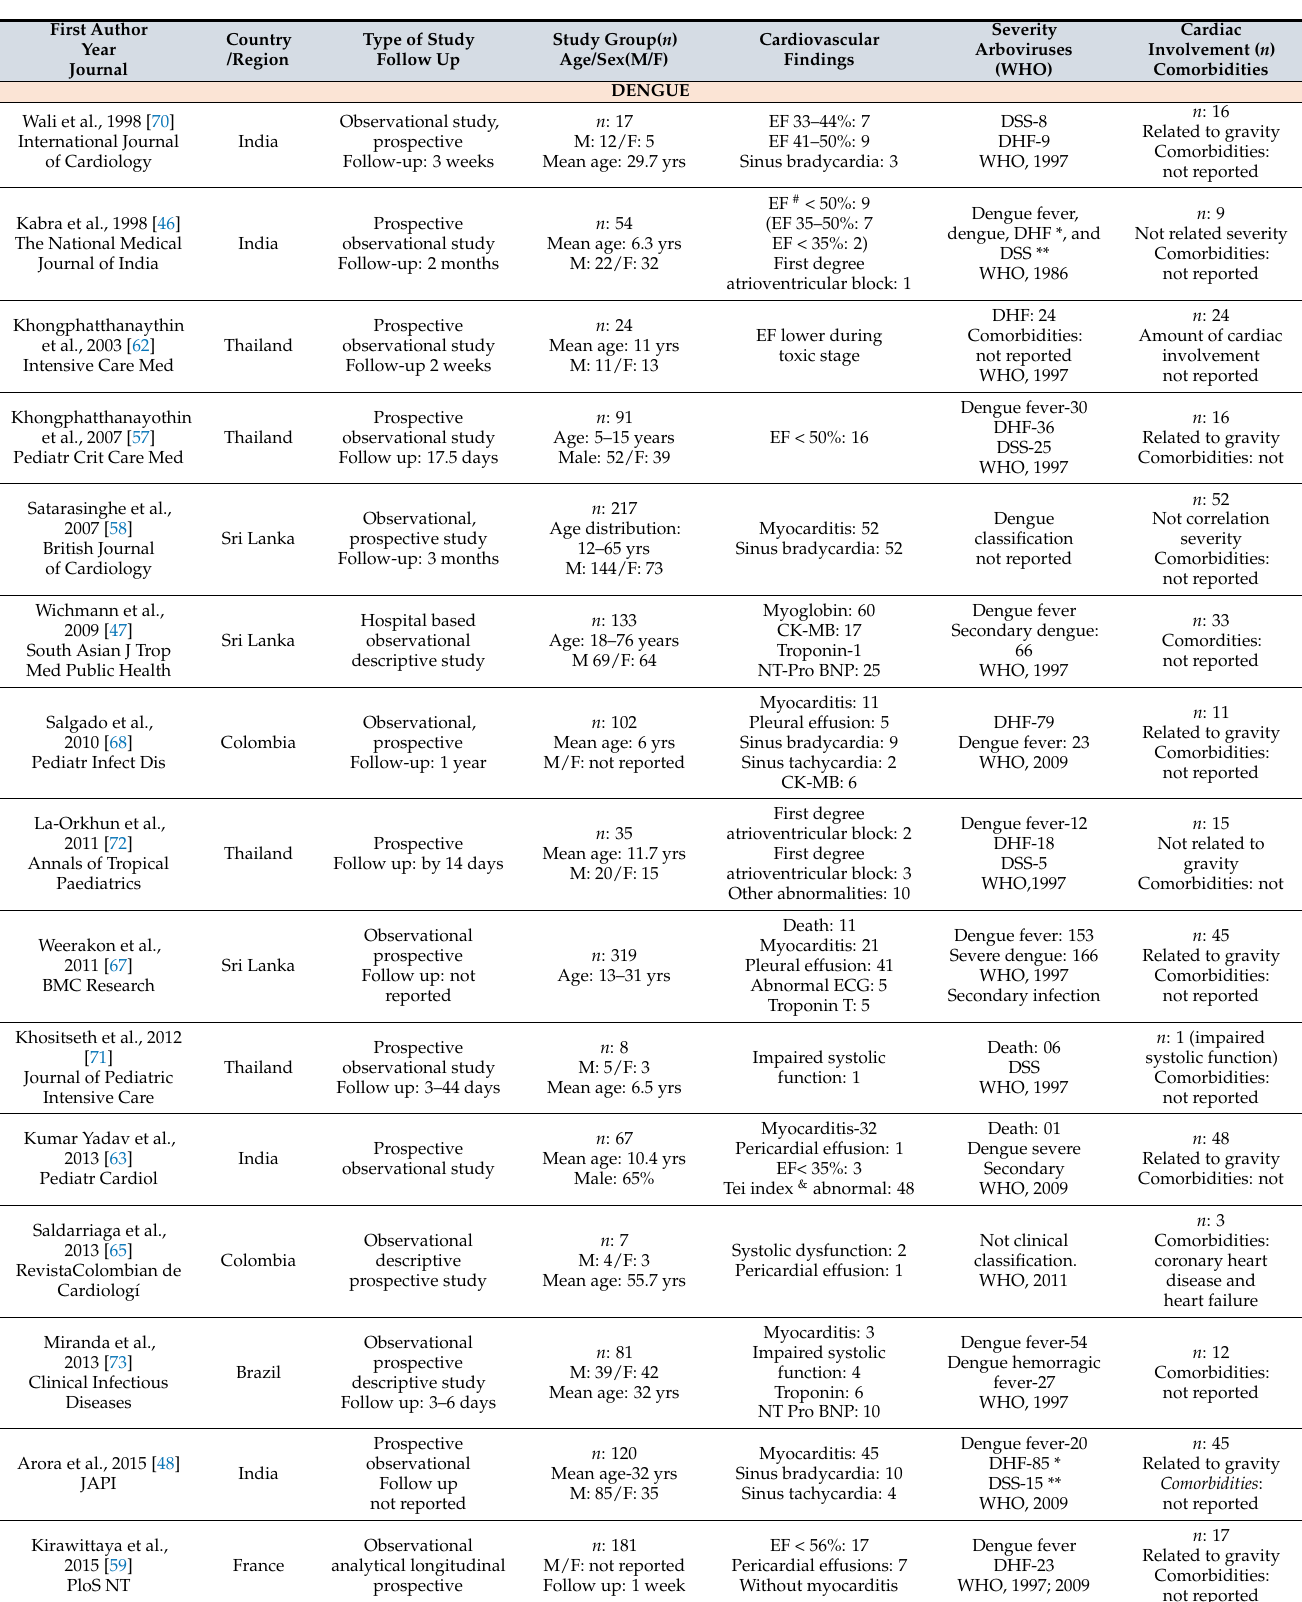
Table 1. Summary of the included